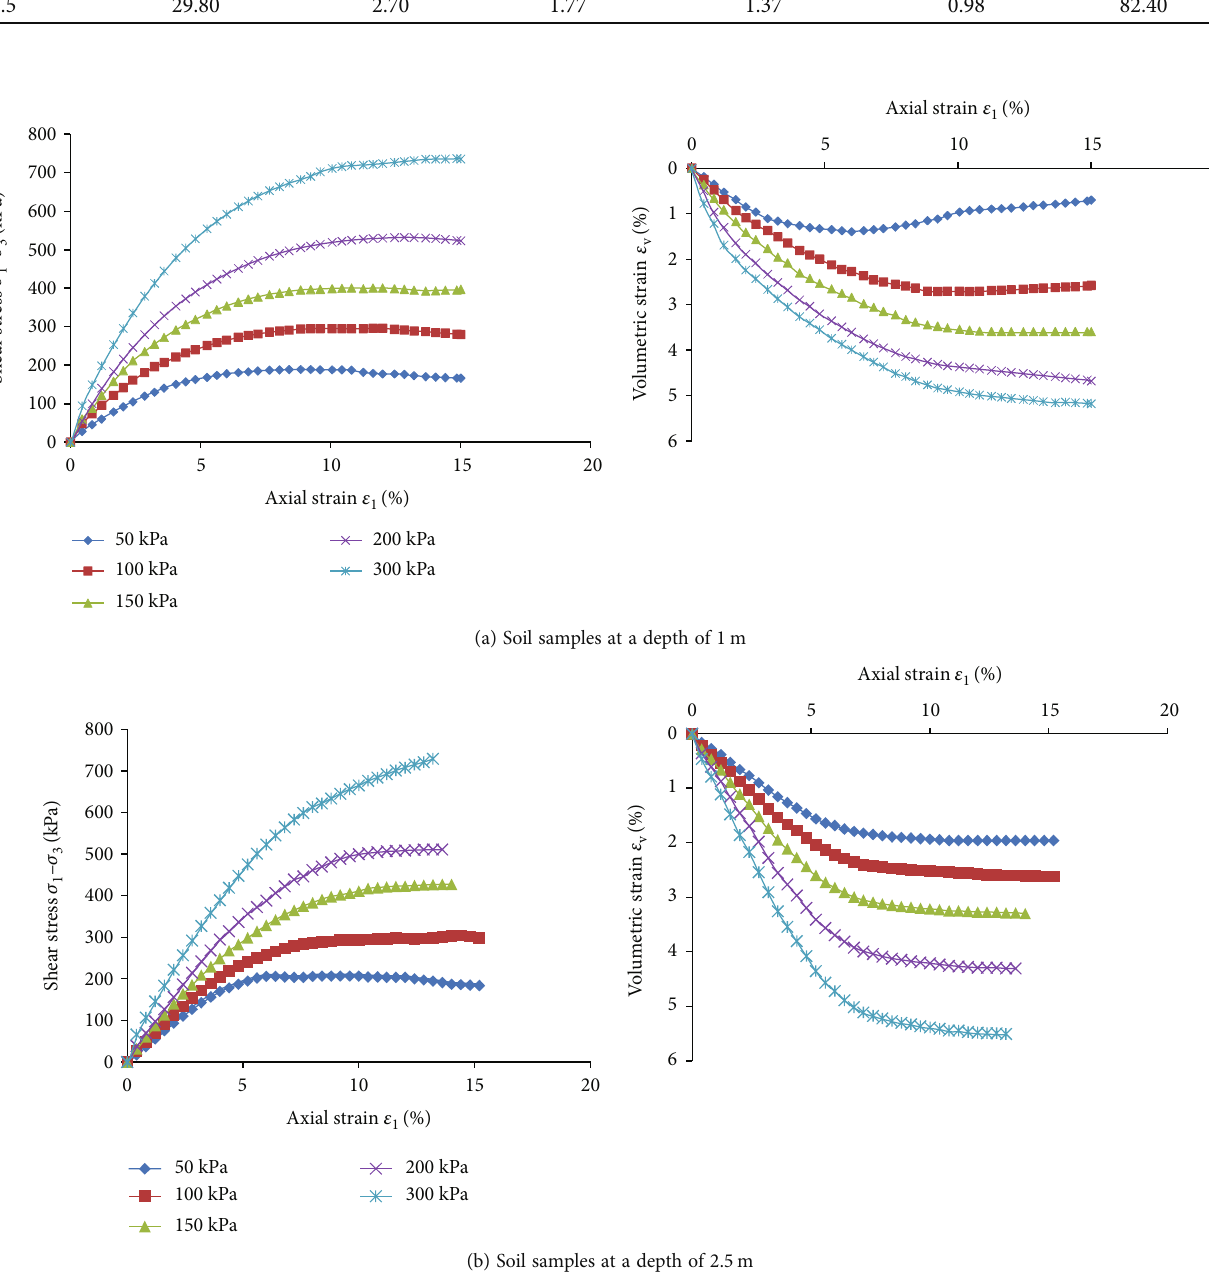
Figure 2: Stress-strain curves of the conventional triaxial compression tests (di ff erent con fi ning pressures).